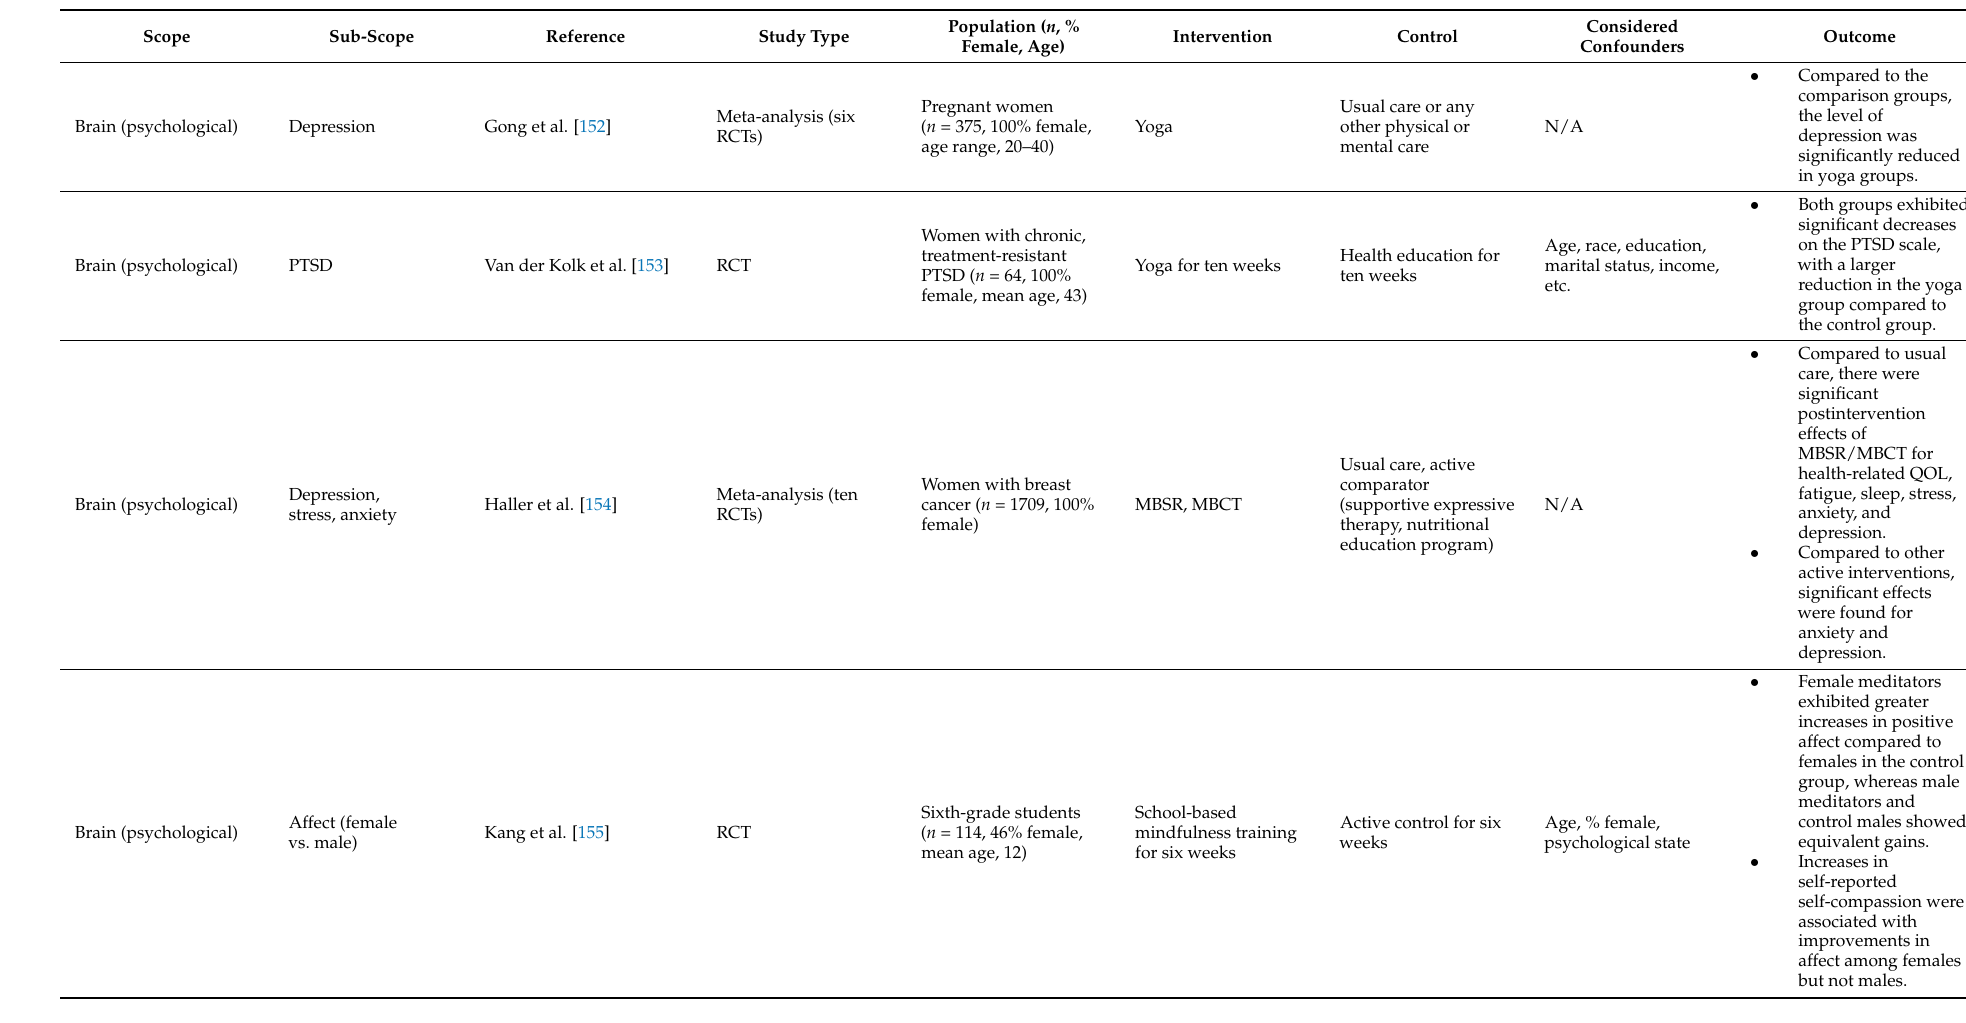
Table 1. Changes in psychological state, heart rate, blood pressure, vasomotor state, cortisol and cytokine secretion by mind–body interventions focusing on